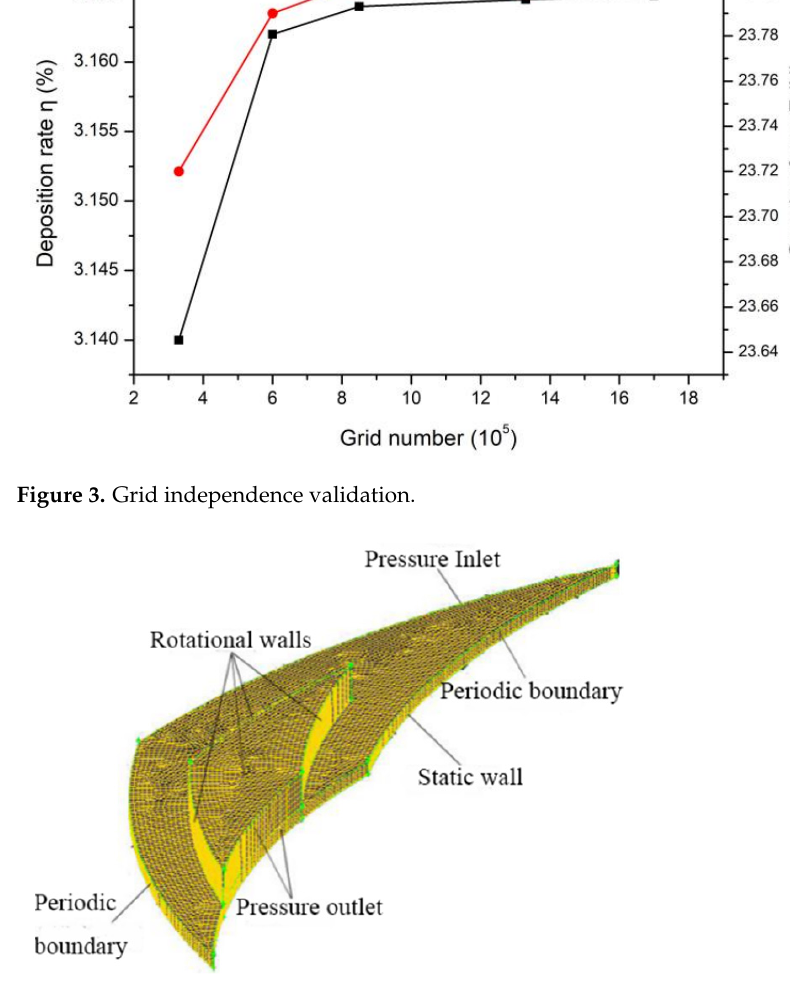
Figure 4. Diagram of 1/N lubrication film mesh and boundary conditions.